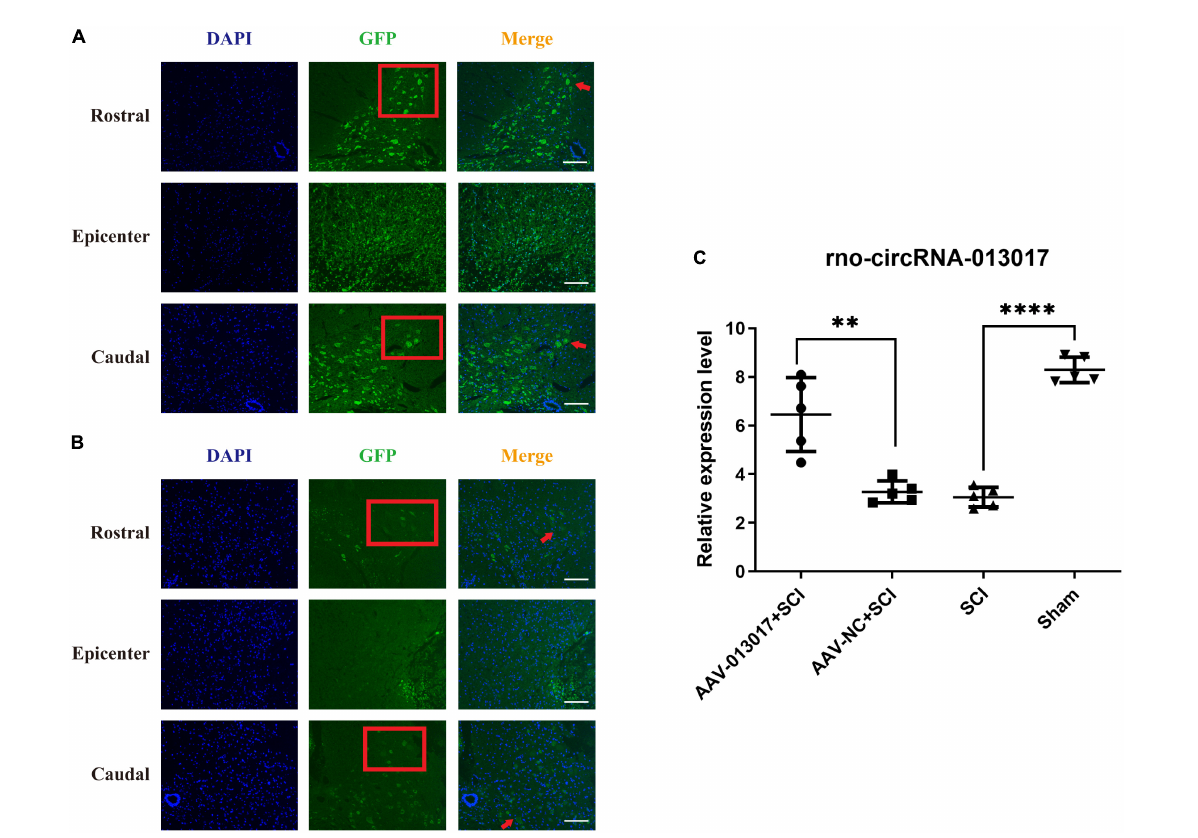
FIGURE1 Overexpression of rno_circRNA_013017 in the spinal cords of rats after an adeno-associated virus (AAV) microinjection at 3 days after spinal cord injury (SCI). (A) Expression of GFP in the AAV-013017 + SCI group was detected by immunofluorescence (IF) staining. Motor neurons in the anterior horn area are indicated by a red arrow ( n = 5 per group). (B) Expression of GFP in the AAV-NC + SCI group, as detected by IF staining. Motor neurons in the anterior horn area are indicated by a red arrow ( n = 5 per group). (C) The rno_circRNA_013017 expression was significantly altered in rats of all groups ( n = 5 per group). AAV-NC (negative control) means AAV with transfected empty plasmid without target gene, compared to AAV with target gene. ∗∗∗∗ Indicates p < 0.0001; ∗∗ indicates p <